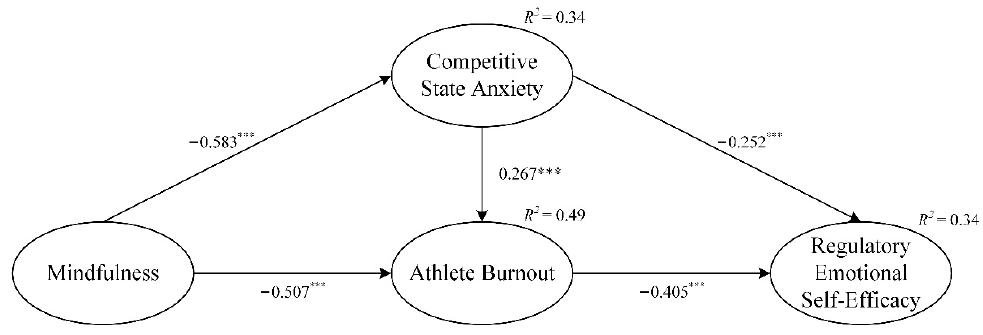
Figure 2. Structural path model. *** p < 0.001. Standardized coefficients are reported. Table 4. Standardized direct, indirect, and total